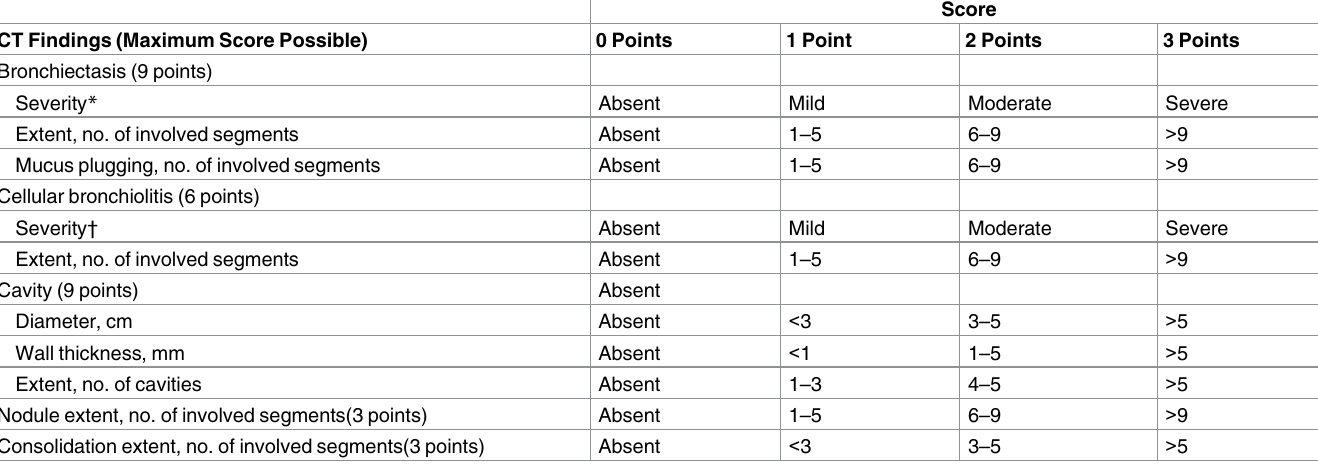
Table 1. Computed tomography (CT) scoring systemfor assessmentof Mycobacterium avium complex (MAC) disease extent.